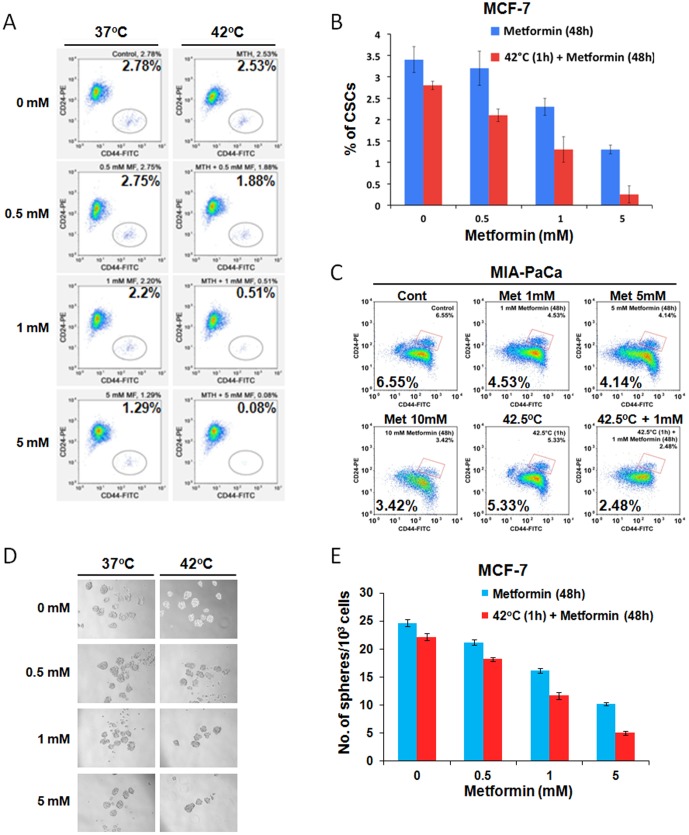
Percent of CSCs in MCF-7 human breast cancer cells treated with hyperthermia and metformin.(A) Cells were incubated with 0–5 mM metformin for 48 h at 37°C, dispersed to single cells and analyzed for CD44high/CD24low cells (CSCs) with FACS. The effect of heating alone was studied by heating the cells at 42°C for 1 h followed by 47 h incubation at 37°C. The combined effect of heating and metformin was studied by heating the cells for 1 h at 42°C with metformin and then incubating at 37°C for 47 h. (B) Experiments described in A were repeated four times and the average of % of CSCs was obtained. Averages of 5 experiments ±1 S.E. are shown. The decreases in CSCs by 1 mM and 5 mM alone were statistically significant. The decrease in CSCs by heating at 42°C for 1 h was also statistically significant. The combinations of heating and metformin were statistically more effective than metformin alone. (C) MIA PaCa-2 cells were incubated with 0–10 mM metformin for 48 h at 37°C, dispersed to single cells and analyzed for CD44high/CD24high cells (CSCs) with FACS. The effect of heating alone was studied by heating the cells at 42.5°C for 1 h followed by 47 h incubation at 37°C. The combined effect of heating and metformin was studied by heating the cells for 1 h at 42.5°C with metformin and then incubating at 37°C for 47 h. (D, E) MCF-7 cells were plated in ultralow attachment plate (1,000 cells/plate) in sphere media. Metformin was added to the media (0.5–5 mM), then heating at 42°C for 1 h. Thereafter, the cells were incubated for 8 days under the standard culture conditions. The numbers of spheres with diameter >50 µm were counted under a microscope. The combinations of heating and metformin were statistically more effective than metformin alone.